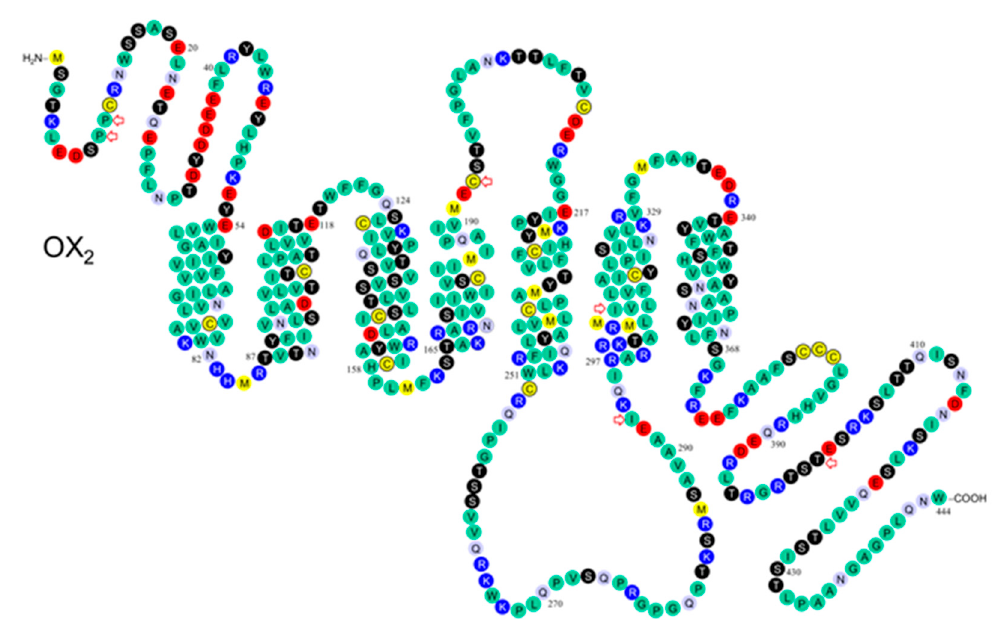
Figure 3. Schematic of the OX 2 receptor in the plasma membrane. Modified from Kukkonen et al. [23]; based on findings of Peyron et al. [10] and Olafsdottir et al. [9]. The variants marked with red arrows are: OX 2 10 Pro/Ser, OX 2 11 Pro/Thr, OX 2 193 Cys/Ser, OX 2 293 Ile/Val, OX 2 308 Ile/Val, and OX 2 401 Thr/Ile [2].